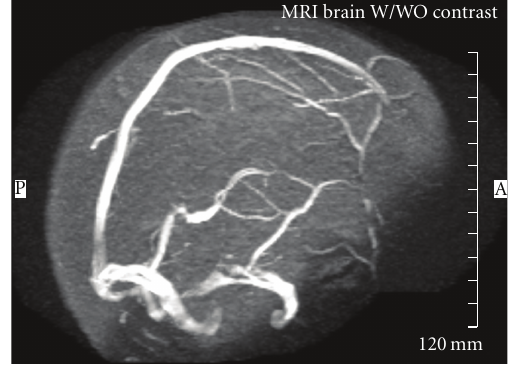
Figure 5: MRV at 1month follow-up after